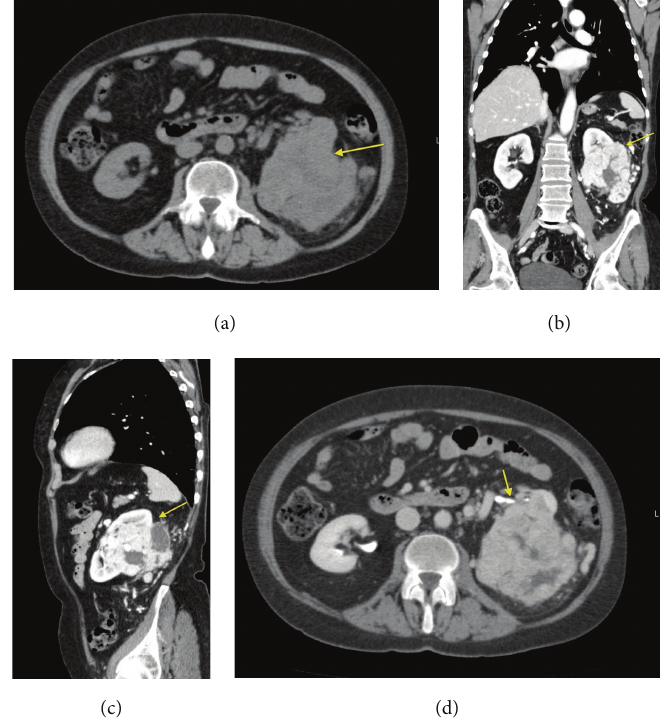
Figure 1: (a) and (b) show the presence of the renal lesion with multilobulated shapes, in the left kidney, 90 mm (LD) × 85 mm (TD) × 96 mm (APD) in size. (c) and (d) show the extension and the location of the renal lesion, mass infiltrates the renal pelvis and the mid calyx (c), and proximal ureter was encased but not infiltrated (d). Arrows indicate the lesion. (a) Axial CT scan, precontrast phase. (b) CECT, multiplanar reconstruction (MPR) Coronal Plane. (c) CECT-MPR: Sagittal Plane. (d) Axial-CECT, urographic phase.